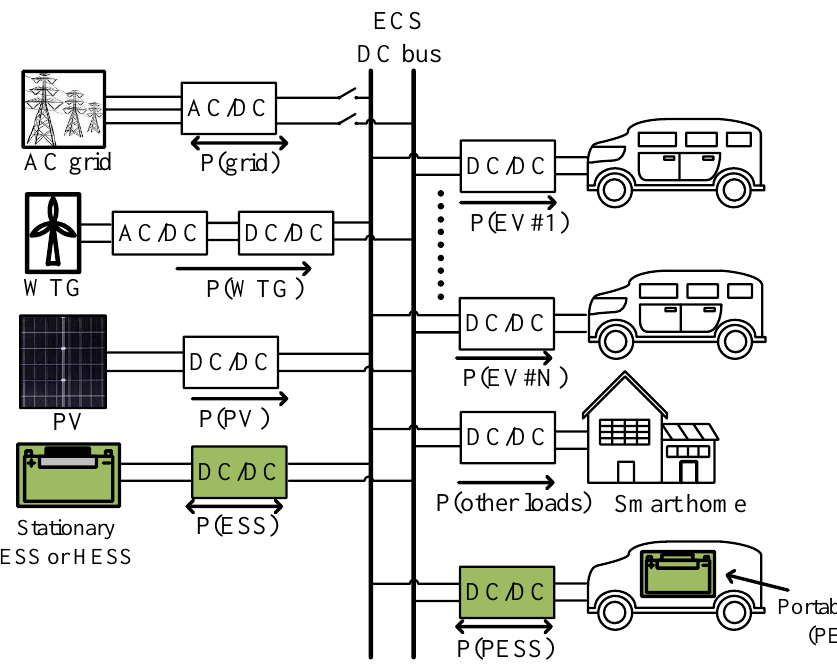
Figure 9. The system configuration of a grid-connected ECS with RE power generation, a stationary ESS and a portable ESS.